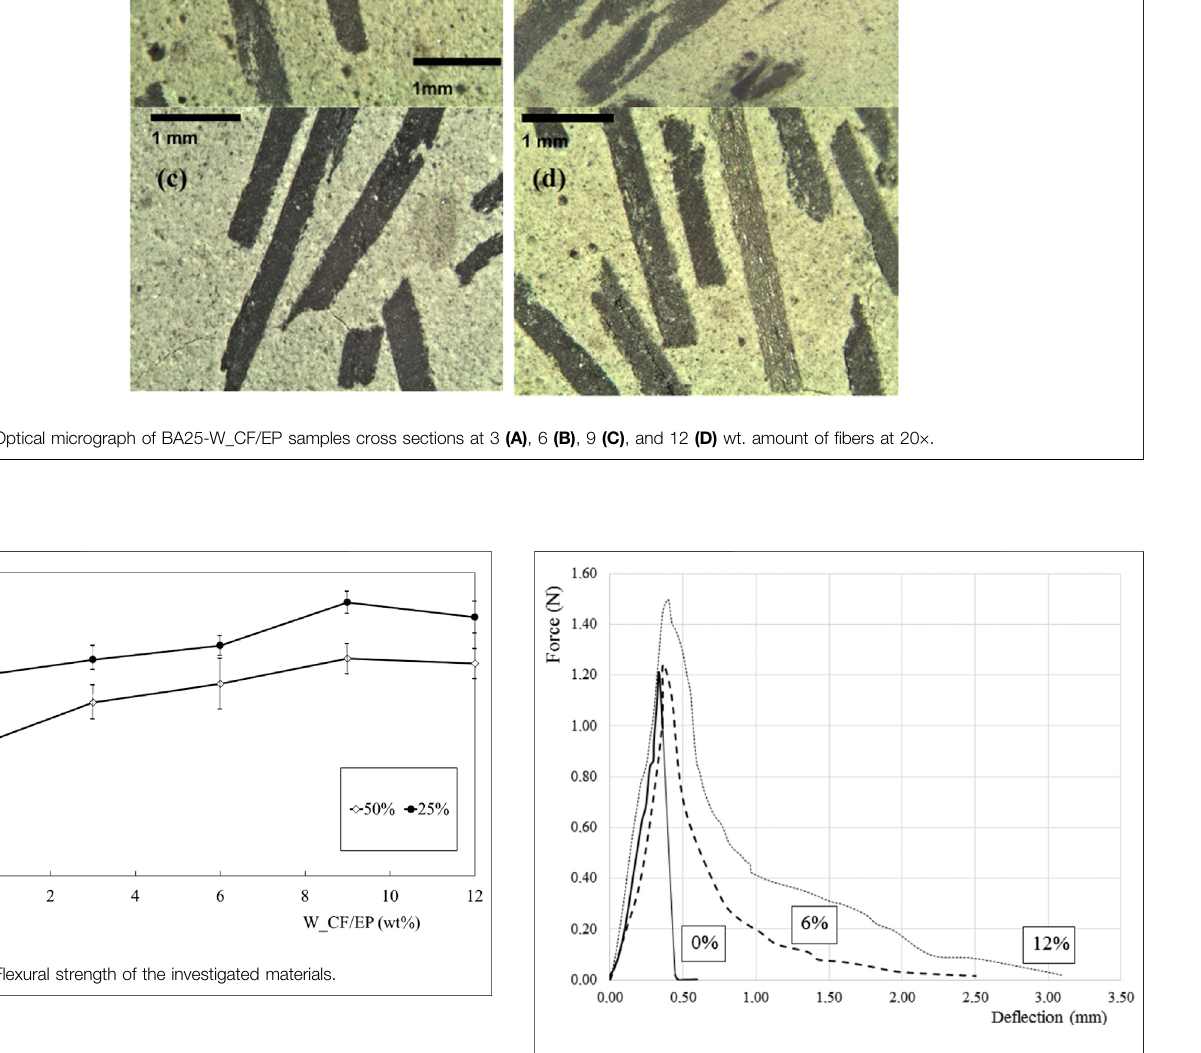
FIGURE 7 | Force vs de fl ection plot of specimens containing 50% of BA at different amounts of